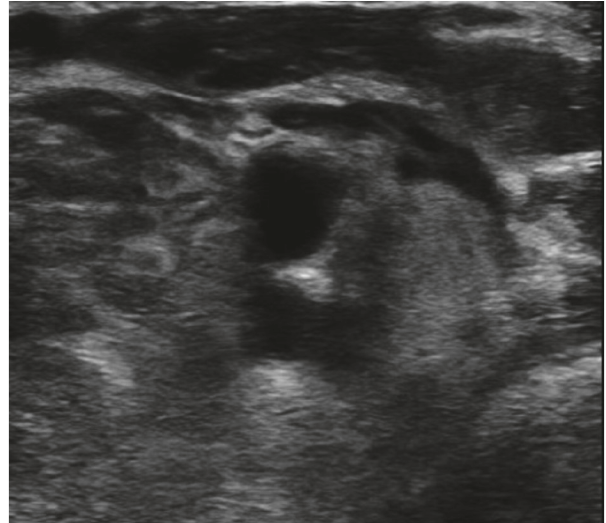
Figure 6: Venous ultrasound with Doppler of left upper extremity showingfindingssuggestiveofanonocclusiveDVTofproximal/mid left subclavian vein which is difficult to